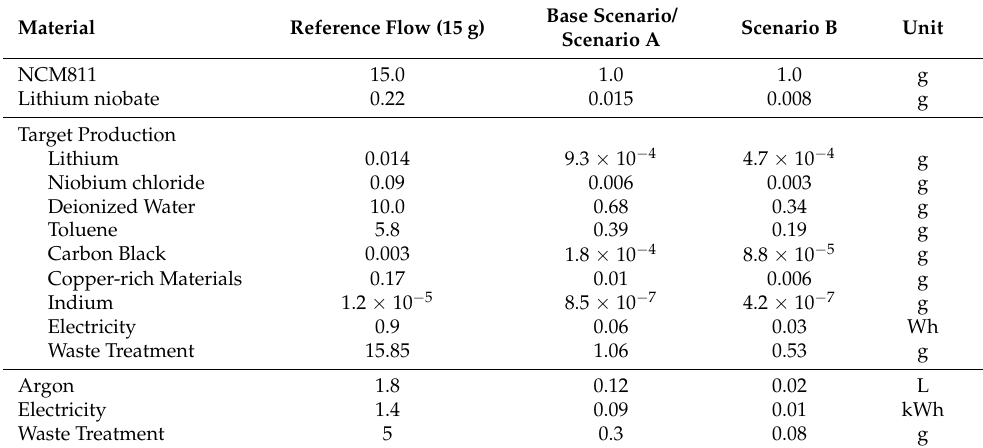
Table 8. LCI data for the PVD/MS Process Scenarios